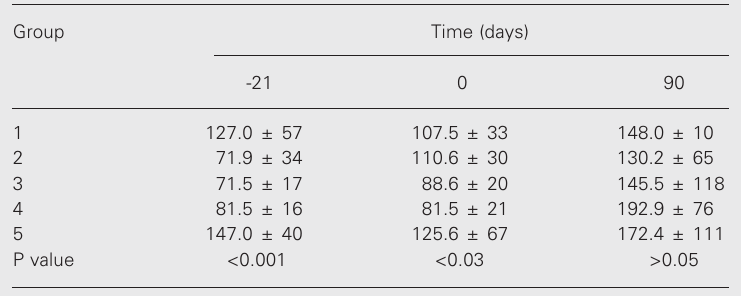
Data are reported as means ± SD (mg/dl). Kruskal-Wallis test H in each time course was time -21 = 15, time 0 = 4 and time 90 = 26.